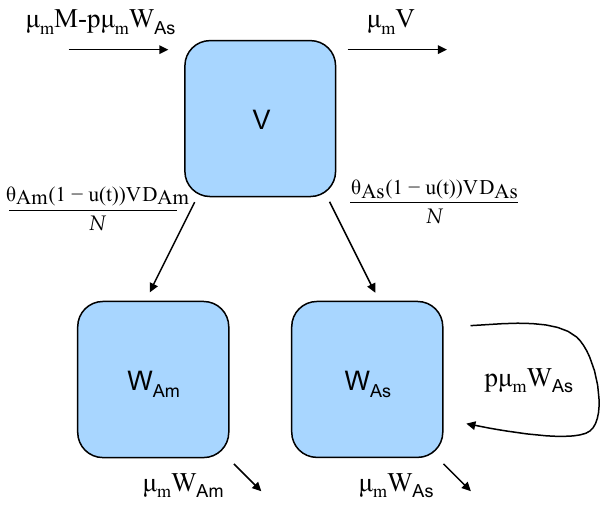
Figure 2. Vector model flow diagram: V is the class of susceptible female mosquitoes that can become infected with either DENV-2 American genotype W Am or DENV-2 Asian genotype W As via contact with an infectious human, D carrying the corresponding genotype. Vertical transmission only occurs in mosquitoes infected with genotype Asian. In this model, there is a constant birth rate, but a proportion, p , of those births by mosquitoes carrying genotype Asian, W As , enter directly into the infectious class. Note that the control function ( 1 − u ( t ) ) is modeled as the reduction efforts in the transmission rate from V either to W Am , or W As